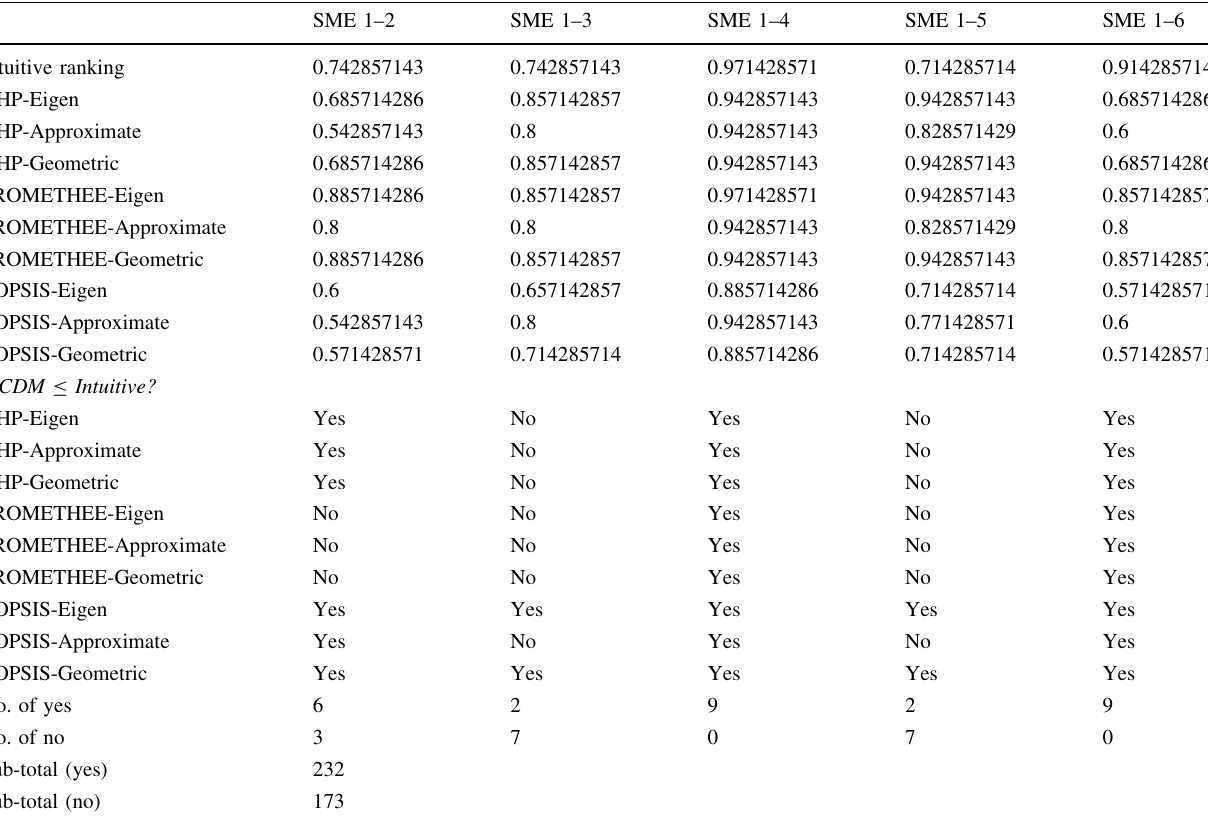
Table 19 Summary Kendall’s coefficients of concordance